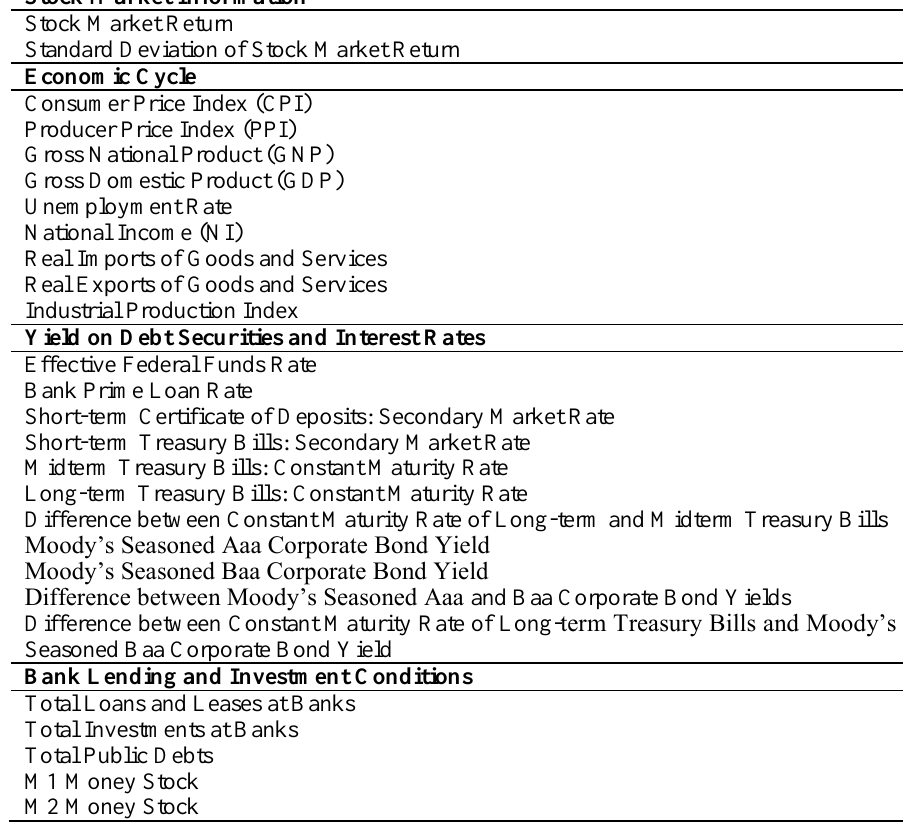
Table (3). Macroeconomic Indicators Affecting Corporate Default Stock Market